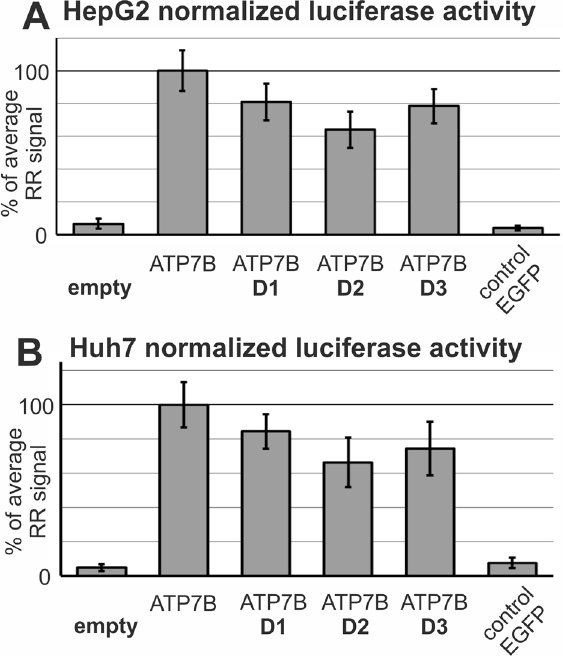
Figure 2. Luciferase reporter activity of genetic promoter variants. The experiment was performed as detailed in Materials and Methods. Expression of the luciferase reporter constructs D1 (rs115564351, − 54G > T), D2 (rs762339422, − 36C > T) and D3 (rs759260854, − 32A > G) in HepG2 or in Huh7 liver cells were tested by co-transfection with renilla luciferase standardization vector pGL74. Transfection efficiencies ( renilla